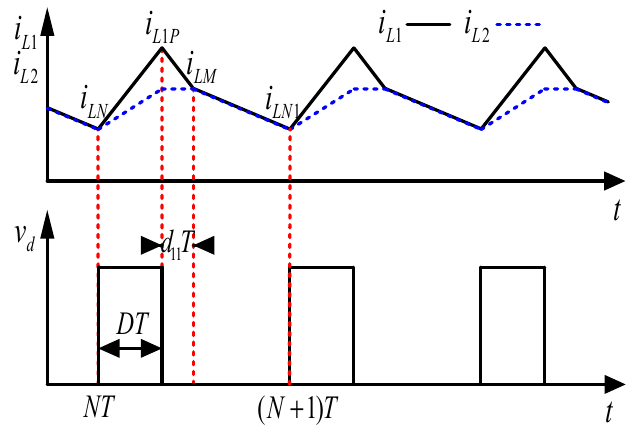
Figure 3 . Typical time-domain waveforms about i L 1 , i L 2 and v d for the proposed step-up converter under L 1 < L 2 .